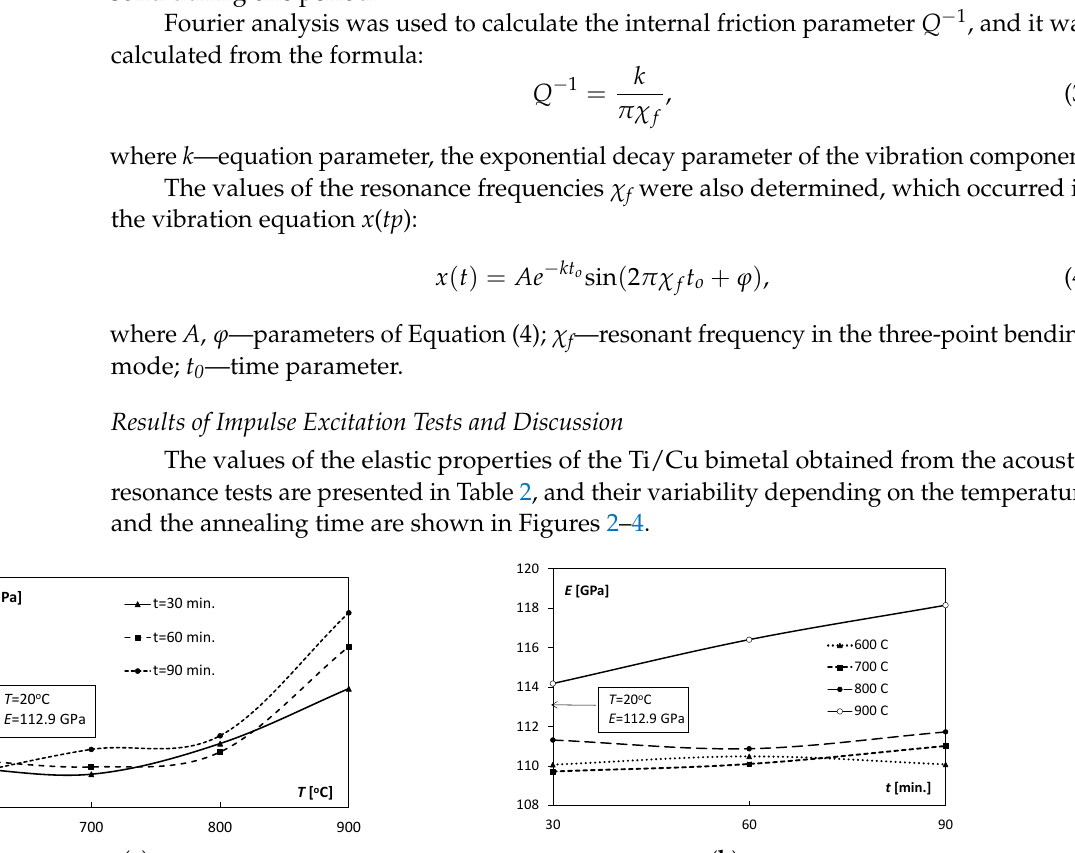
( b ) Figure 3. Dependence of the internal friction parameter χ f on: ( a ) temperature , ( b ) annealing time t . ( a ) ( b ) Figure 4. Dependence of the internal friction parameter Q − 1 on: ( a ) temperature T , ( b ) annealing time t .